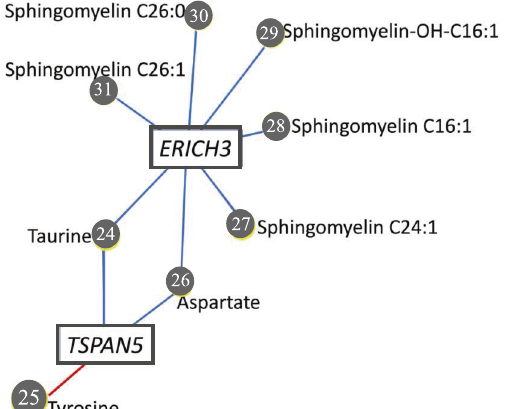
Fig. 3 Multi-omics integration network analysis. A Multi-omics integration network. Each metabolite is labeled with a number. Metabolite names corresponding to these numbers can be found in Supplementary Table 6. Correlation values between metabolites and SNPs can be found in Supplementary Table 7. B Labeled and enlarged community-2 containing sphingomyelins. Represented genotypes are: TSPAN5 (rs10516436), ERICH3 (rs696692), AHR (rs17137566), DEFB1_1 (rs5743467), DEFB1_2 (rs2741130), DEFB1_3